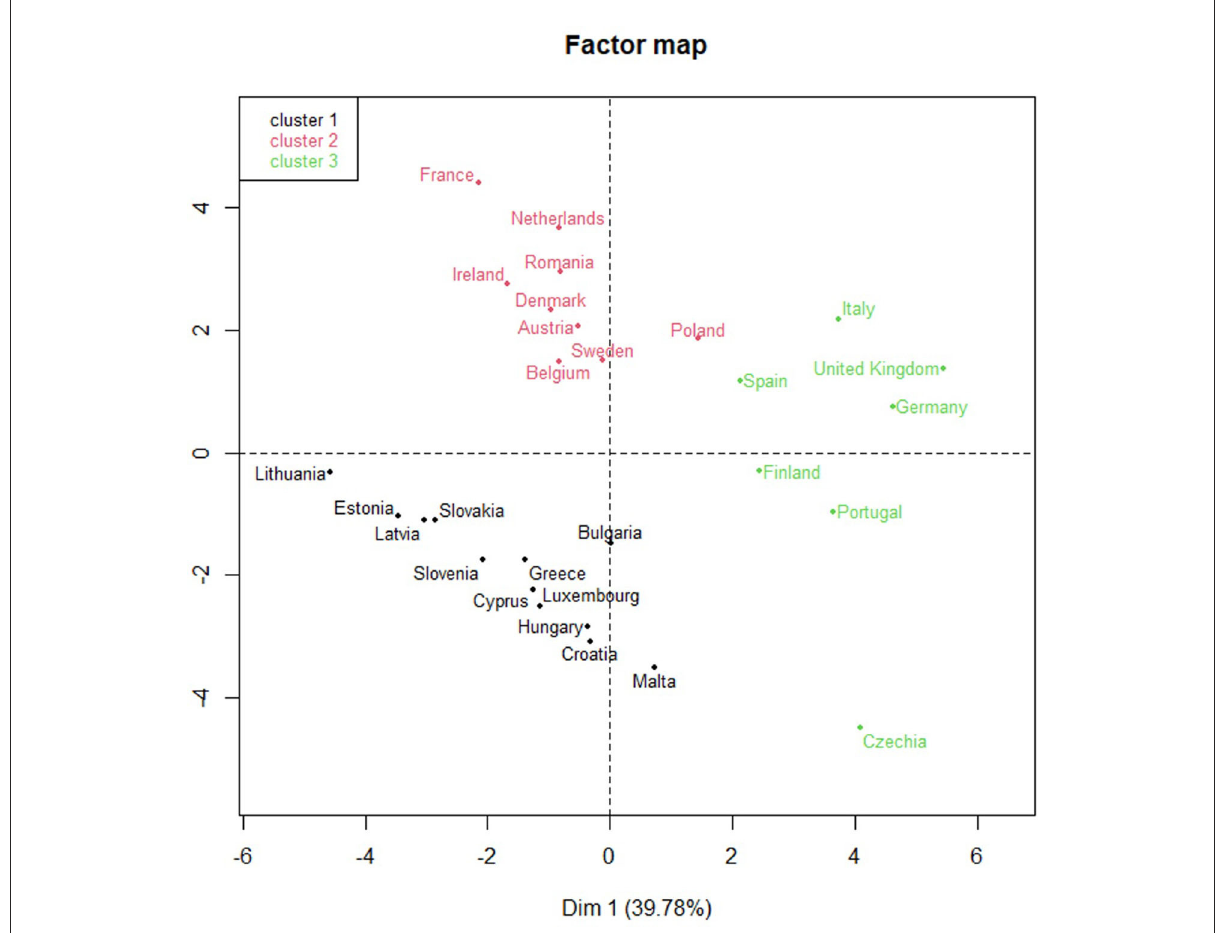
FIGURE12 Classification of European countries by three